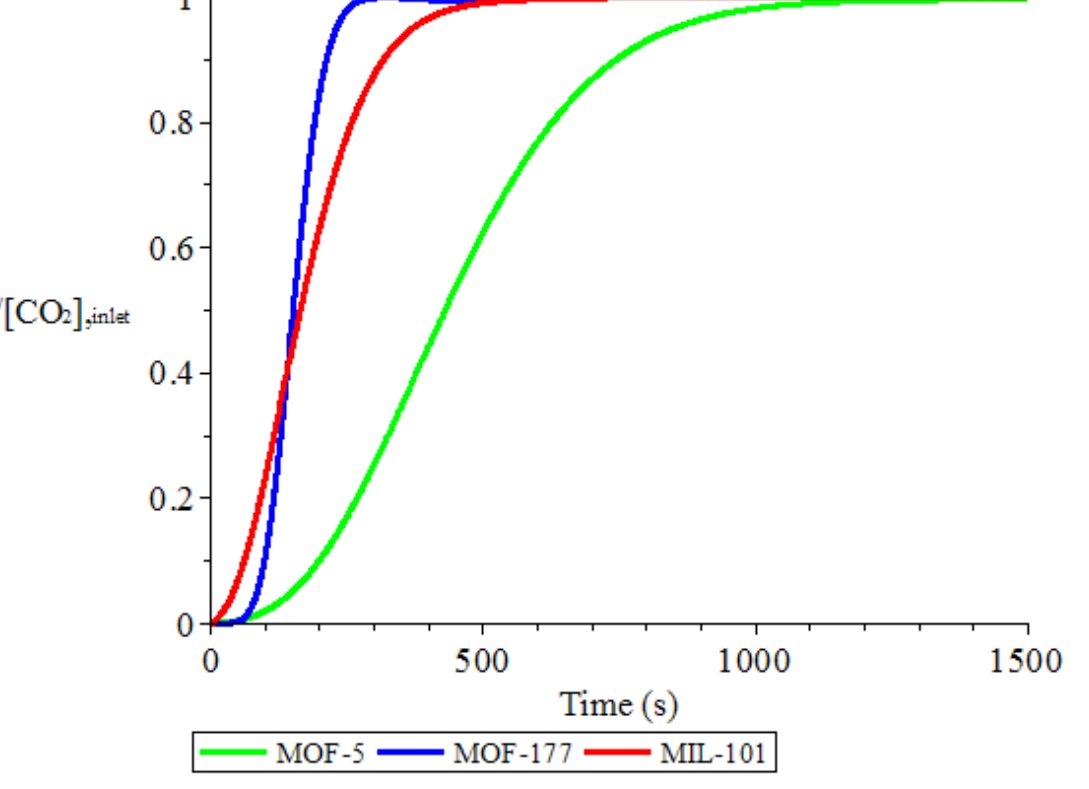
Figure 3. Breakthrough curves (CO 2 concentration at the outlet/CO 2 concentration at the inlet) for physisorbents .